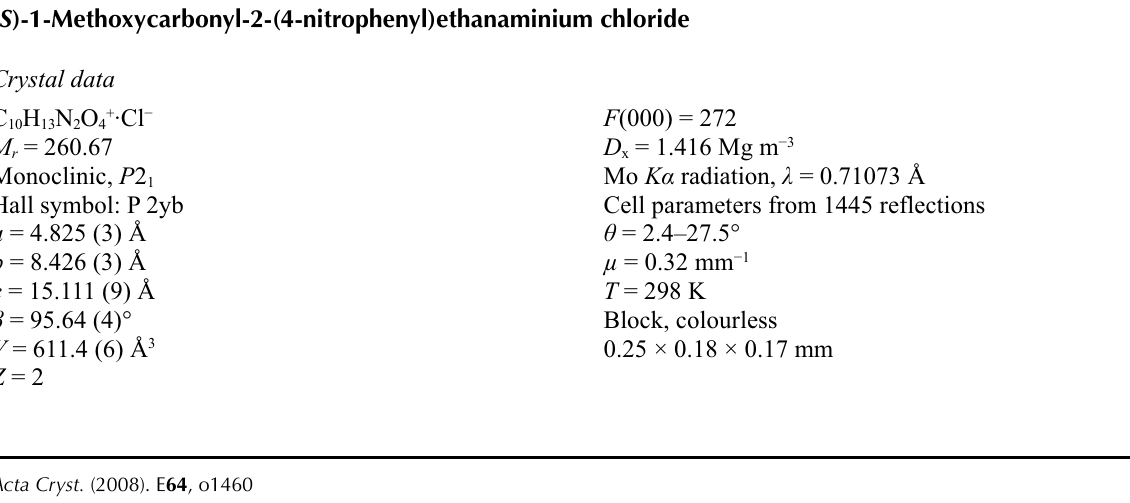
The crystal packing of the title compound viewed along the b axis and all hydrogen atoms not involved in hydrogen bonding (dashed lines) were omitted for